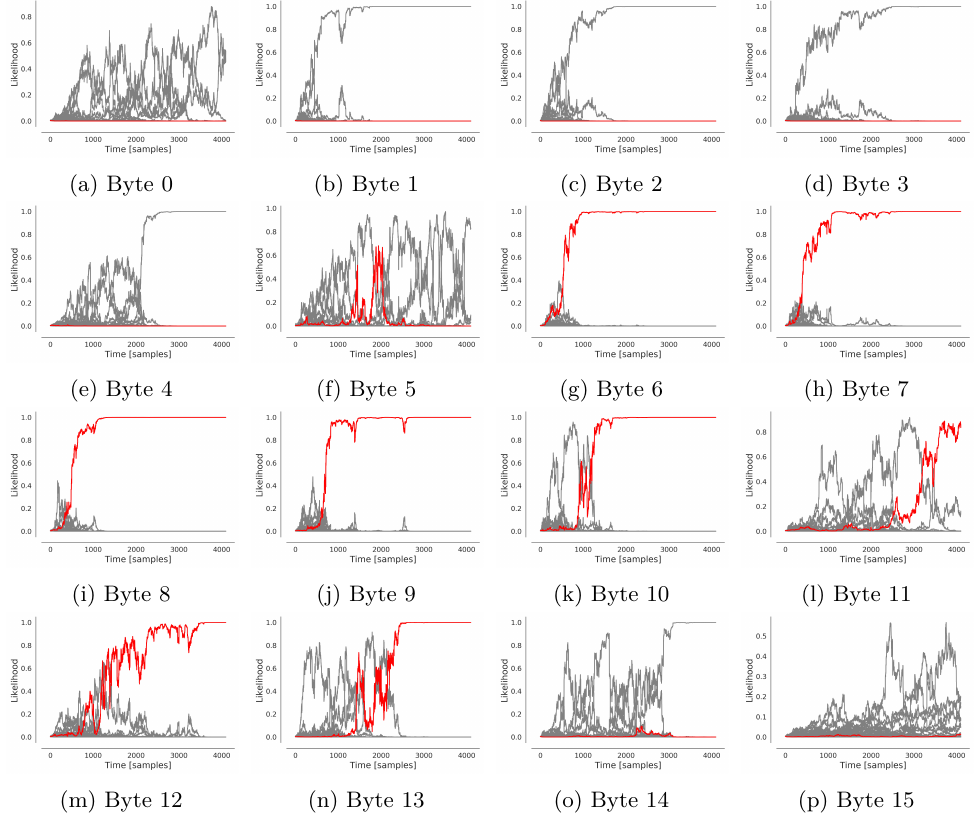
Figure 39: Recovery of the 16 key bytes in the last round of AES-CTR on CortexM4 with blind SCA, using 4 096 traces. The red lines indicate the correct